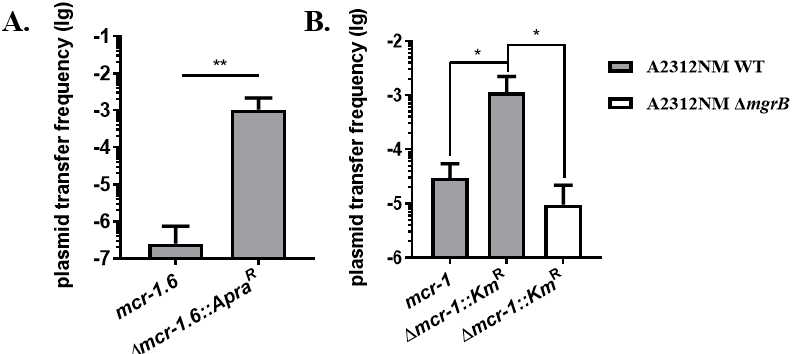
Figure 3. The impact of plasmid or chromosome mediated colistin resistance on plasmid transfer. ( A ) Transfer frequency of mcr-1 .6 plasmid and Δ mcr-1 .6 ::Apra R plasmid from K. pneumoniae A2312NM to E. coli MP13. ( B ) mcr-1 -related plasmid transfer frequency. Donor strains were A2312NM Δ mgrB containing Δ mcr-1::Km R plasmid and A2312NM containing mcr-1 plasmid or